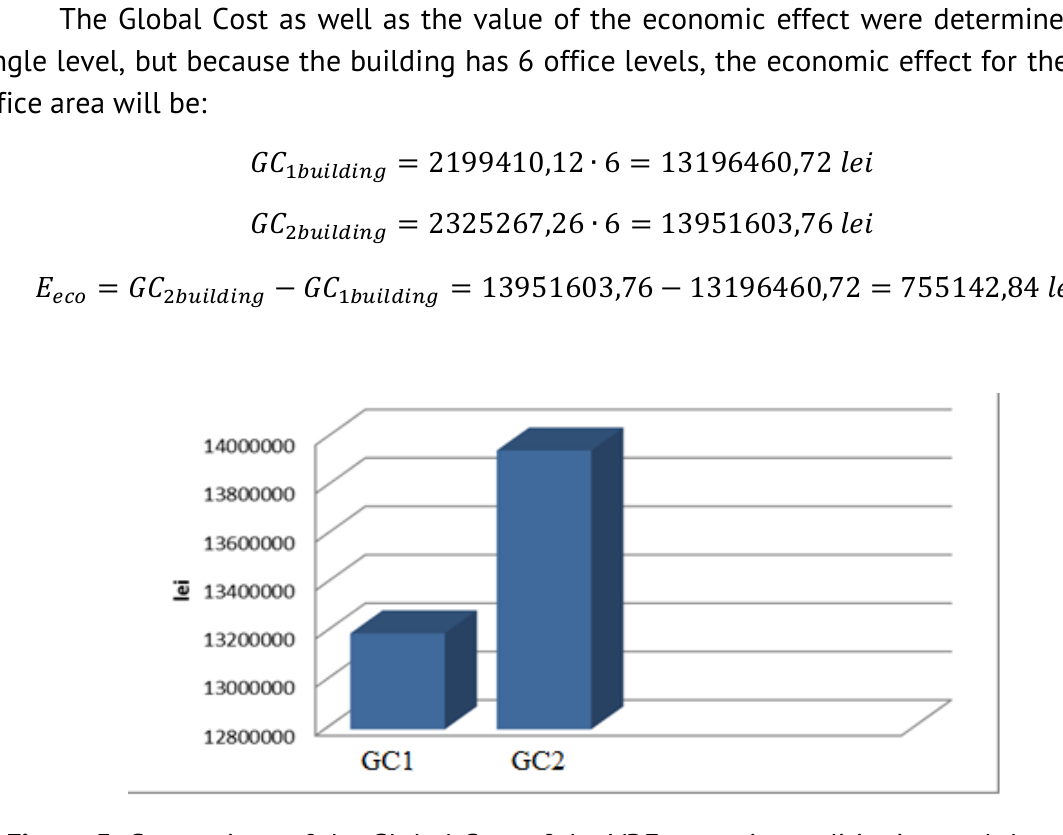
Figure 5. Comparison of the Global Cost of the VRF-type air conditioning and the chiller fan-coil